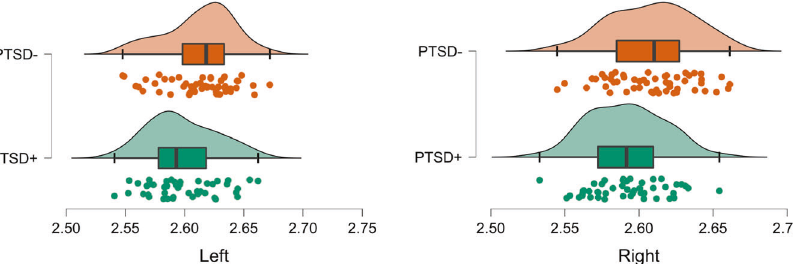
Fig. 3 Raincloud plots showing pairwise comparisons between bilateral cortical complexity between WTC responders with PTSD versus those without. Analyses identi fi ed lower absolute cortical complexity in the PTSD + group in the left hemisphere ( t = − 2.5535, p = 0.0122, Cohen ’ s d = − 0.5139; PTSD + : mean = 2.5979, SD = 0.0290; PTSD − : mean = 2.6128, SD = 0.0289), and the right hemisphere ( t = − 3.1798, p = 0.0020, Cohen ’ s d = − 0.6358; PTSD + : mean = 2.5913, SD = 0.0257; PTSD − : mean = 2.6085, SD = 0.0282), when compared to the PTSD- group. PTSD posttraumatic stress disorder, X -axis denotes hemispheric